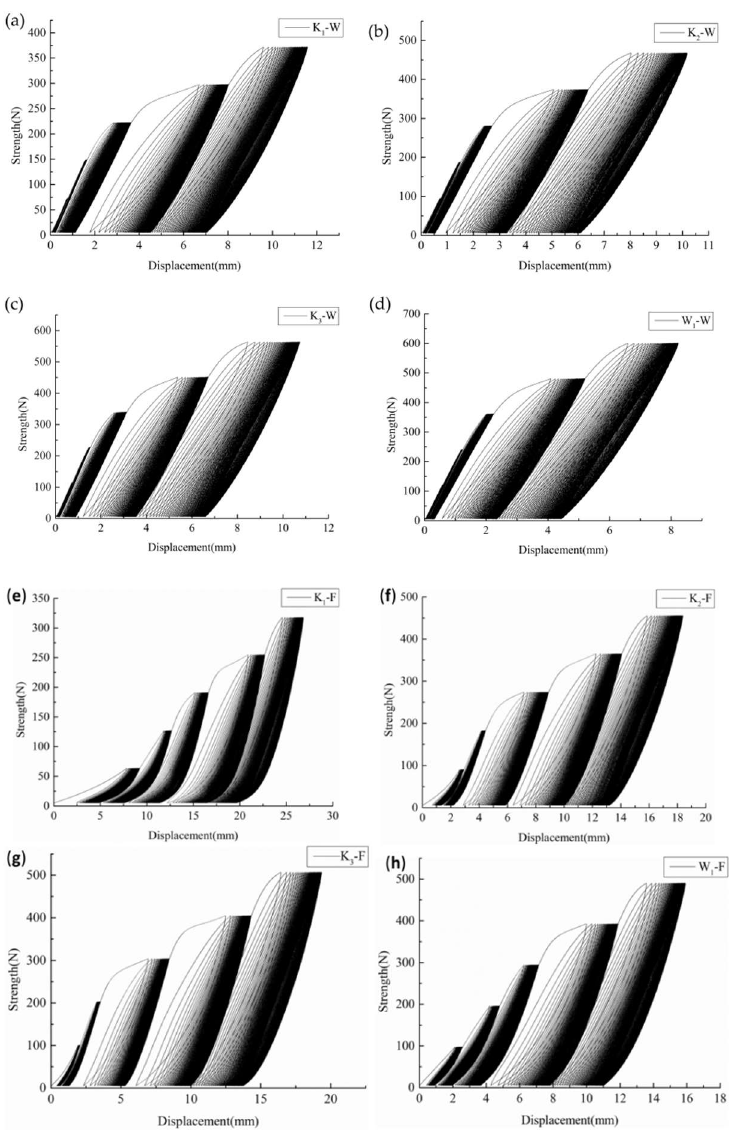
Figure 2. Stress–strain curves of the tested specimens under multistage cyclic loading and un- loading. ( a , b , c , d ) Warp direction of K 1 , K 2 , K 3 , and W 1 ; ( e , f , g , h ) fill direction of K 1 , K 2 , K 3 , and W 1 .